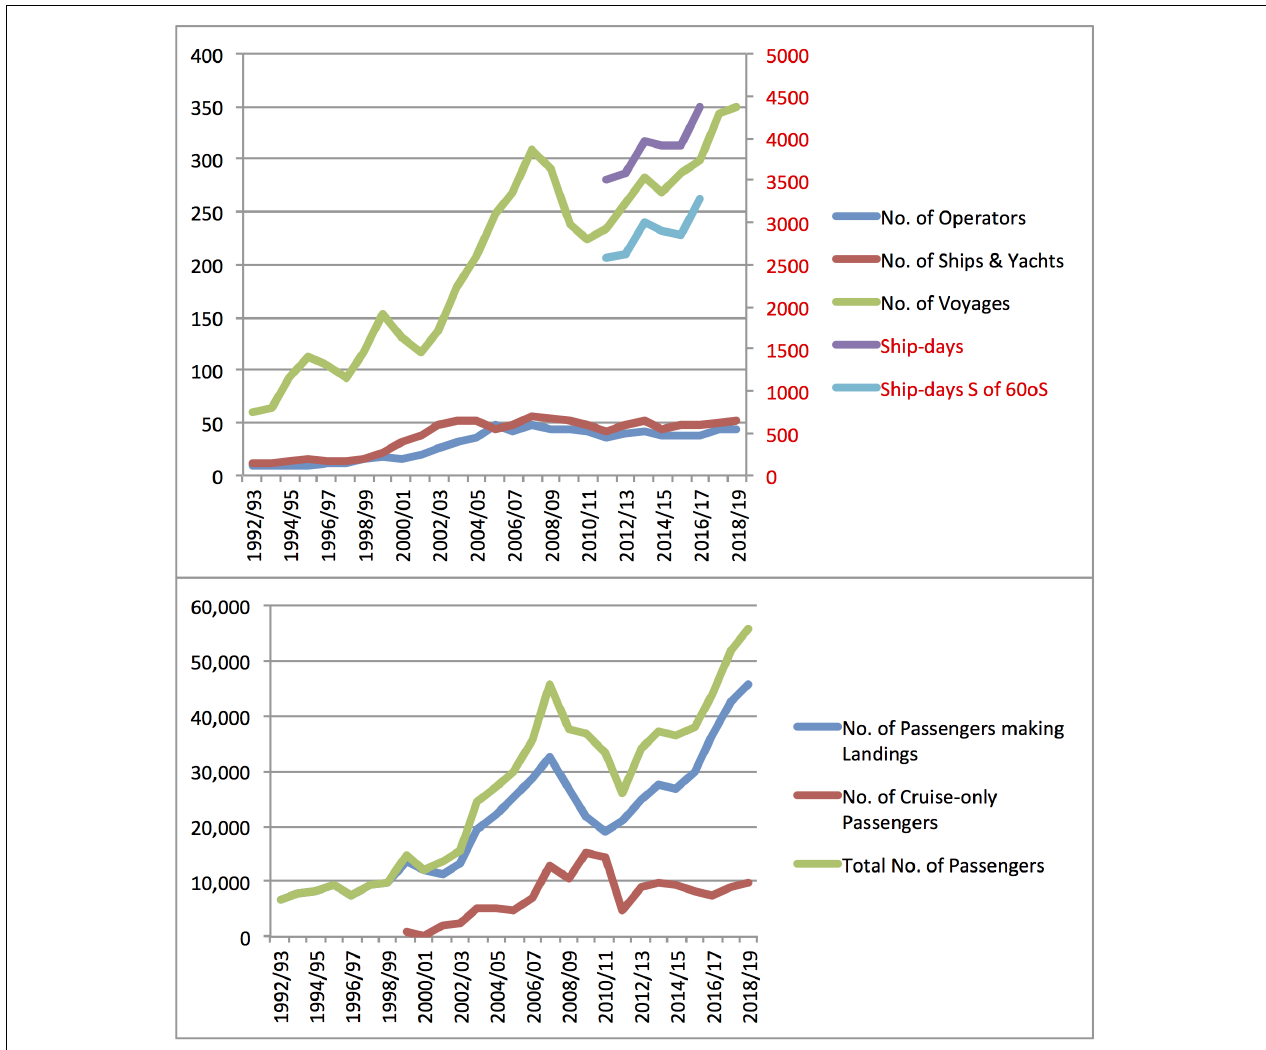
FIGURE 2 | Trends in Antarctic ship-based tourism. For more information on these data, see International Association of Antarctica Tour Operators [IAATO] (2018).